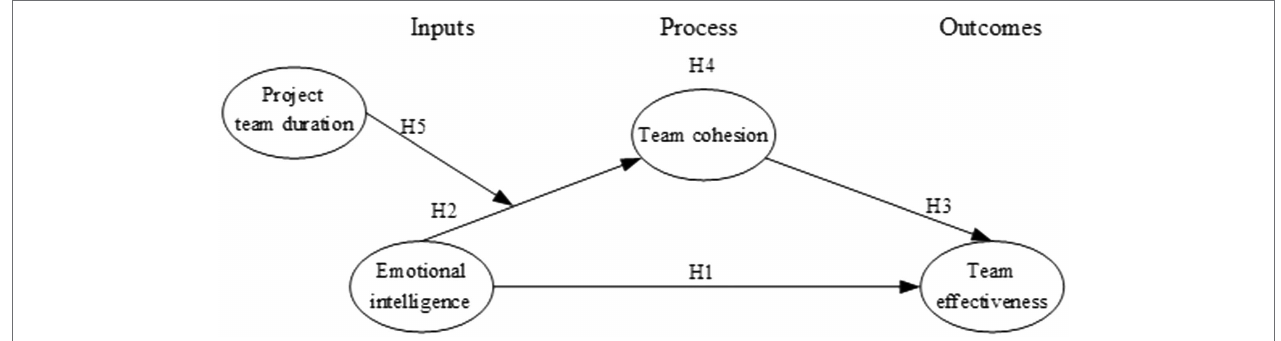
FIGURE 2 | The hypothesized model in the input-process-output